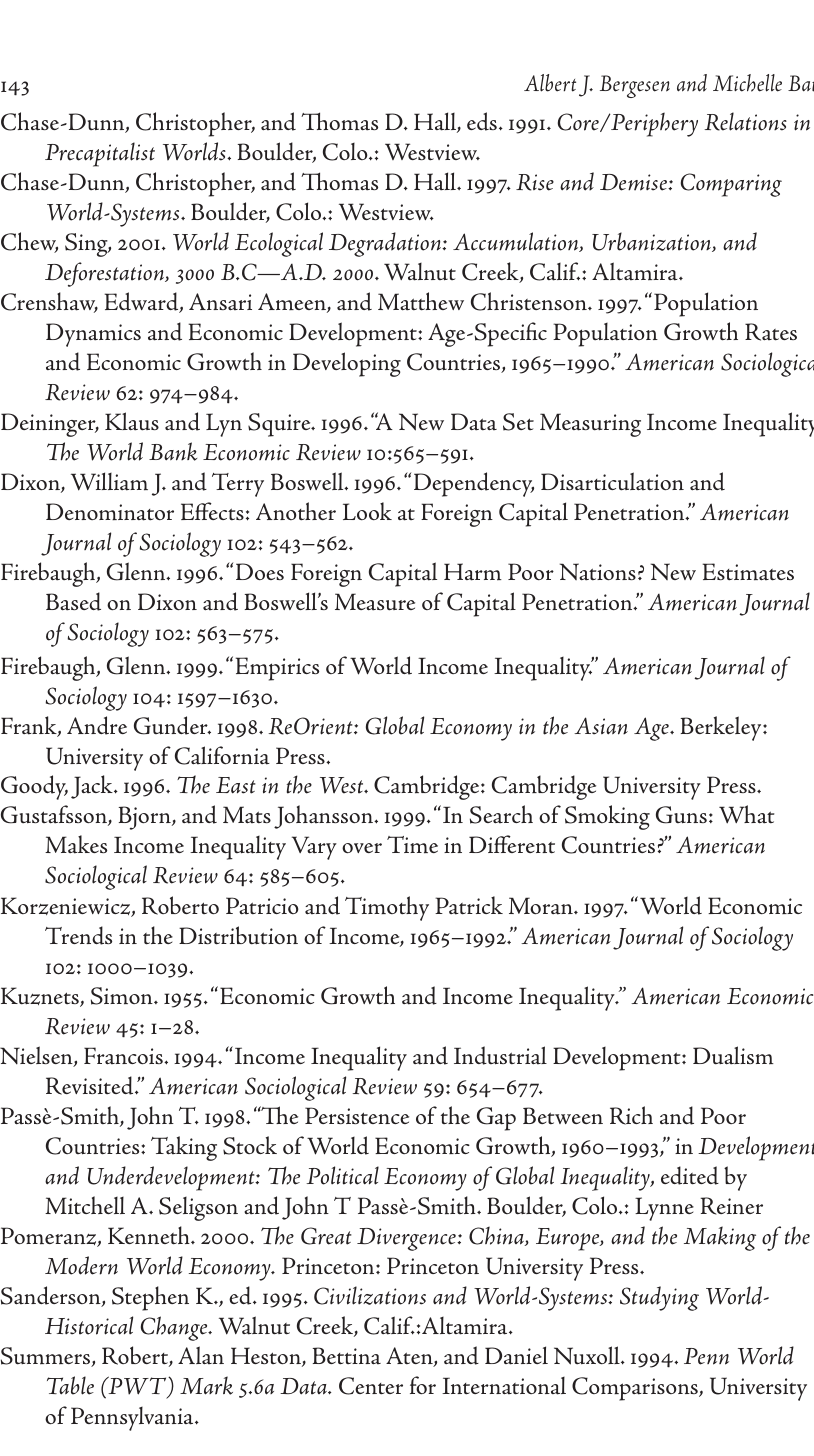
Table (PWT) Mark .a Data. Center for International Comparisons, University of